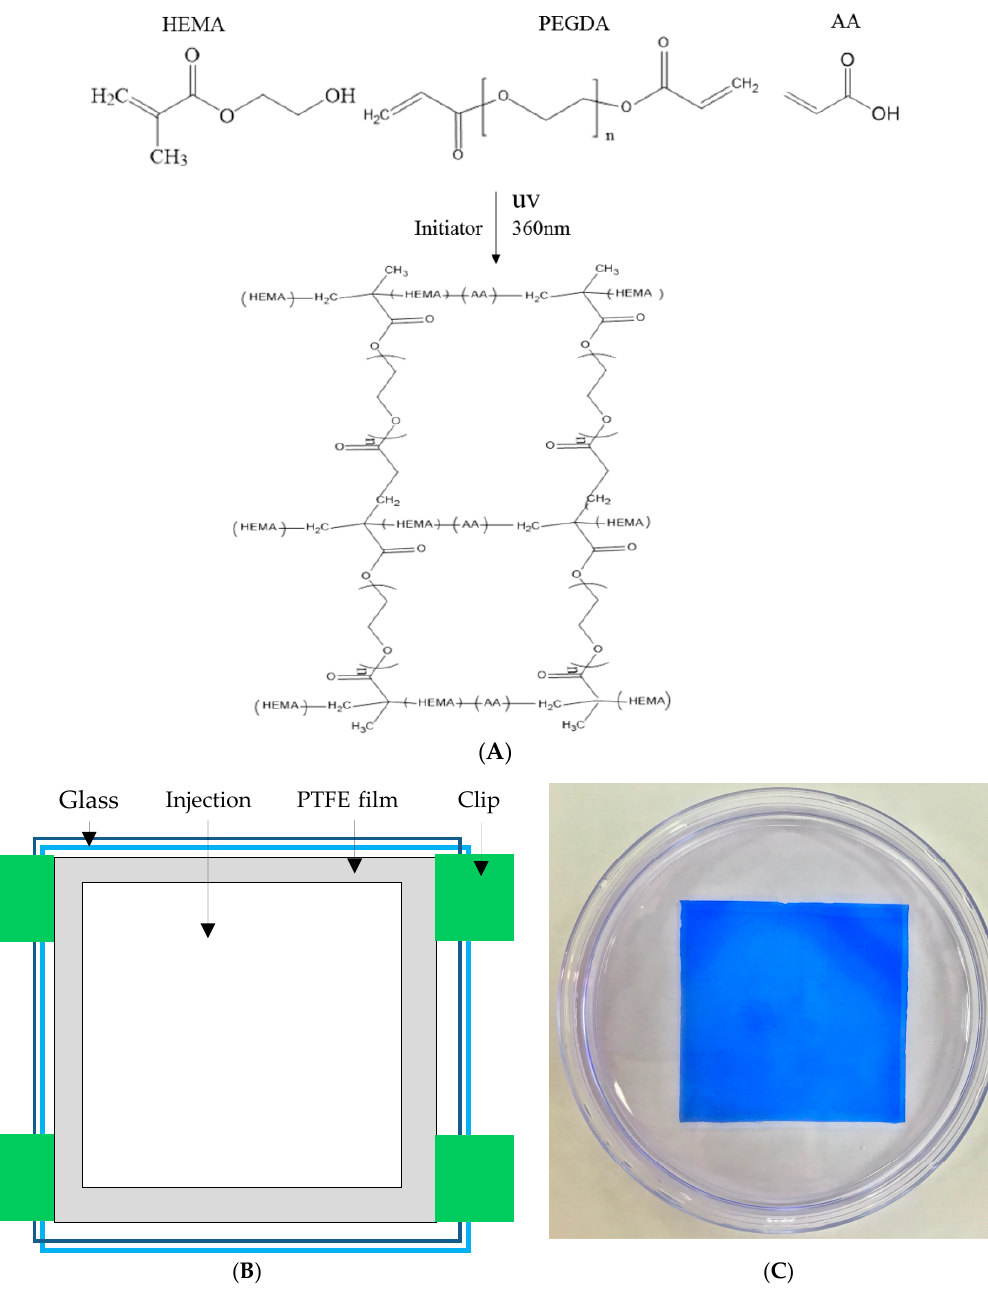
Figure 1. ( A ) Reaction of hydrogel synthesis using UV radiation; ( B ) Device used for hydrogel preparation; and ( C ) Photograph of the hydrogel stained with Coomassie Blue. Table 1. The tensile strength and water contents of different types of hydrogels.